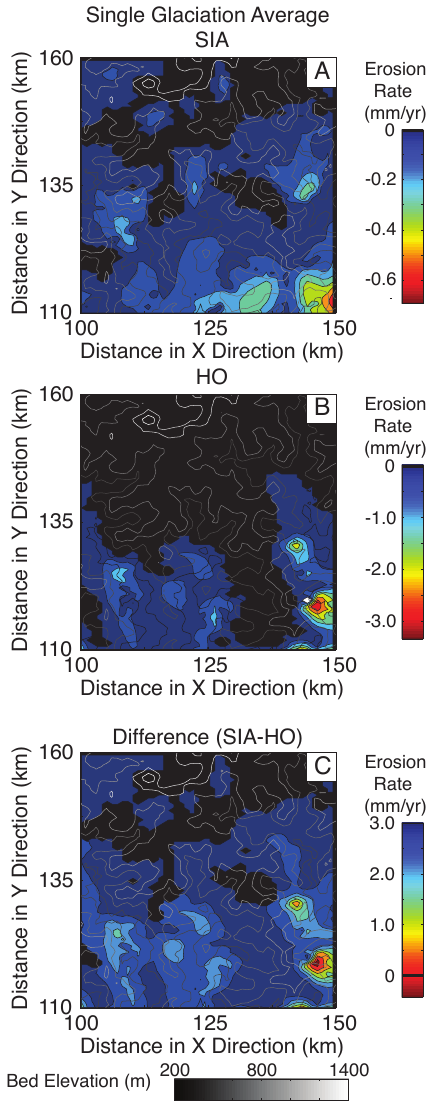
Figure 6. Pattern of erosion rates in nested region (Figs. 1 and 2) averaged over the full simulation. The grey-scale topographic lines show the elevation of the underlying topography. (a) SIA erosion rates, where regions of no erosion are shown in white. (b) HO ero- sion rates, where regions of no erosion are shown in white. (c) Dif- ference between the time-averaged erosion rates